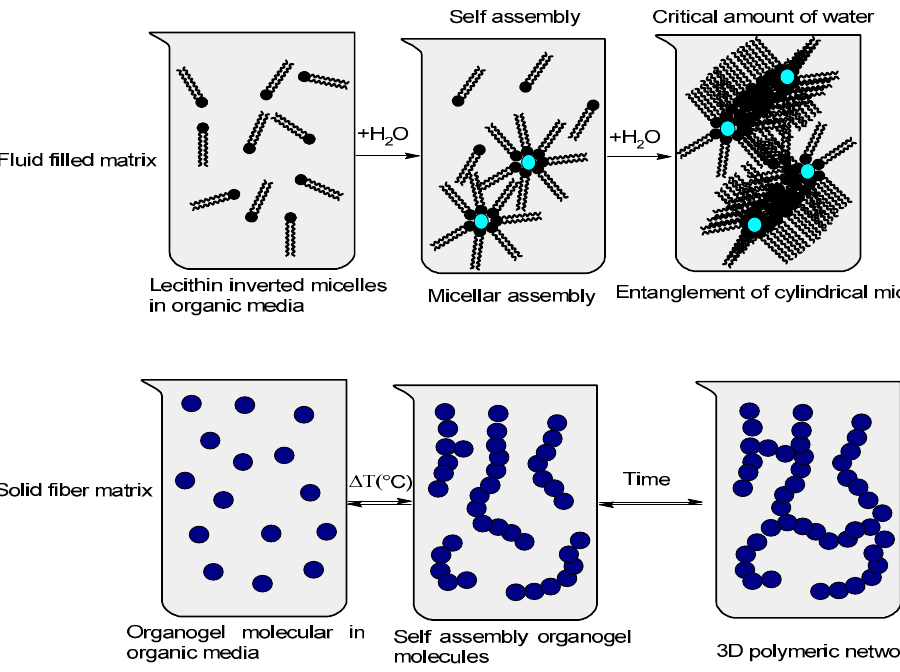
Figure 2. Preparation methods that influence organogel structures. Top panel : example of a liquid-filled matrix. Amphiphilic lecithin molecules organize into inverted micelles in an organic solvent. Bottom panel : example of a solid fiber matrix. The dissolution of organogelator molecules in an organic solvent at high temperature leads to a concentrated solution [32].